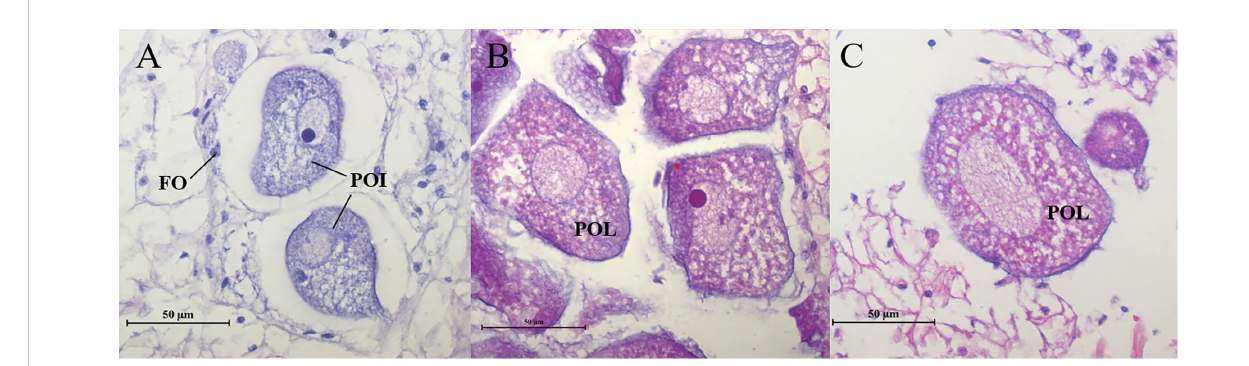
FIGURE 10 Ovaries histological characteristic of C. sinensis under estradiol exposure treatments. (A) control group, (B) 5 µg/L group, (C) 50 µg/L group. POI, pre-vitellogenesis oocyte; POL, post-vitellogenesis oocyte; FO, follicle cells.